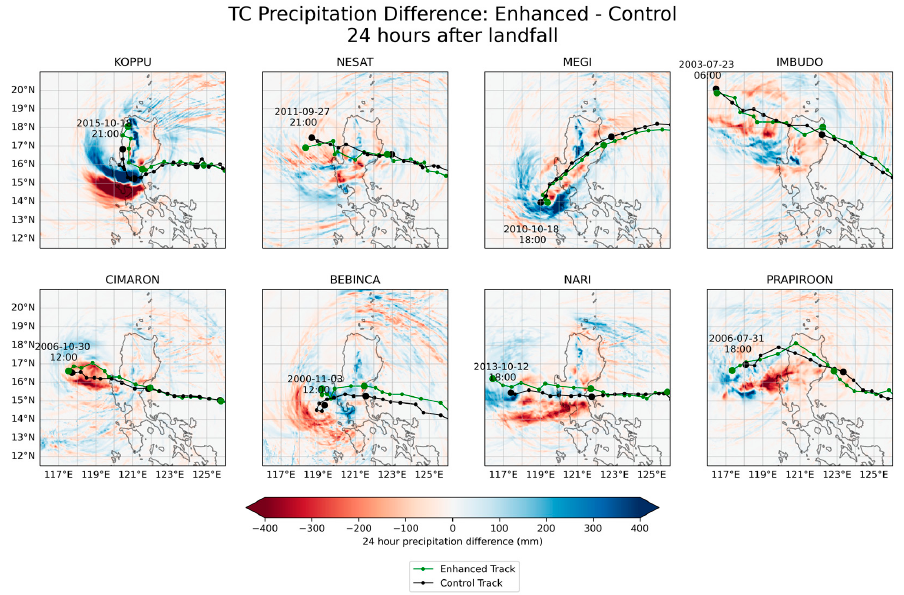
Figure 9. Similar to Figure 7, but for the difference in 24 h accumulated precipitation after landfall between Enhanced and